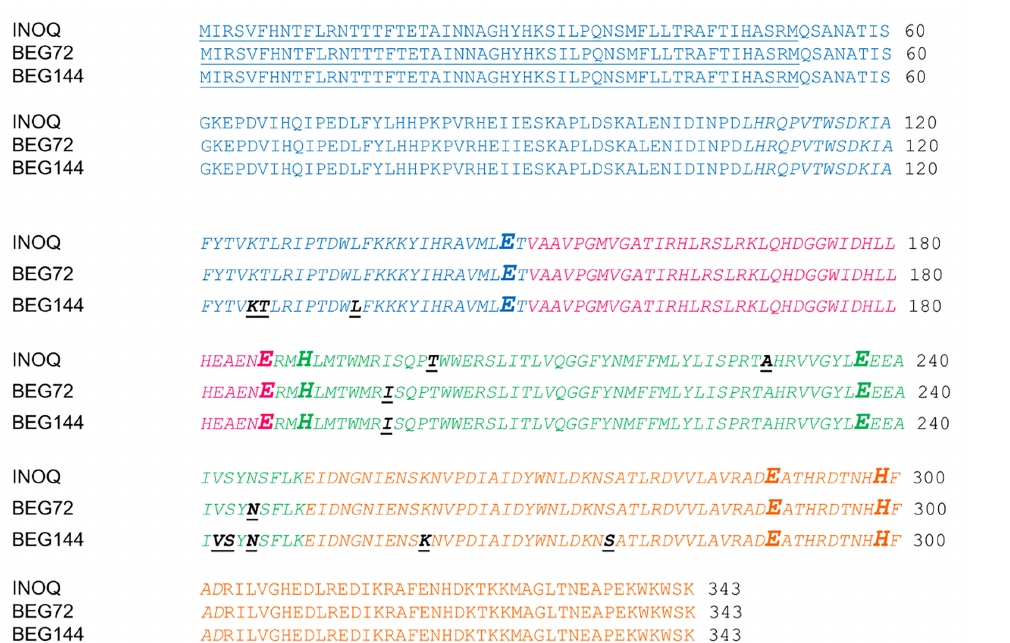
Fig 8. Location of the putative amino acid changes induced by SNVs or MNVs within the AOX ferritin-like domain, in the INOQ, BEG72 and BEG144 isolates. Exons are indicated by different colours. The 52 bp of the predicted N-terminal are underlined. The AOX ferritin-like domain, obtained by nucleotide search on CDD database is italicised. The putative amino acid changes are bold and underlined. The location of the four universally conserved glutamate residues (E) and the two universally conserved histidine residues (H) are presented in bold and